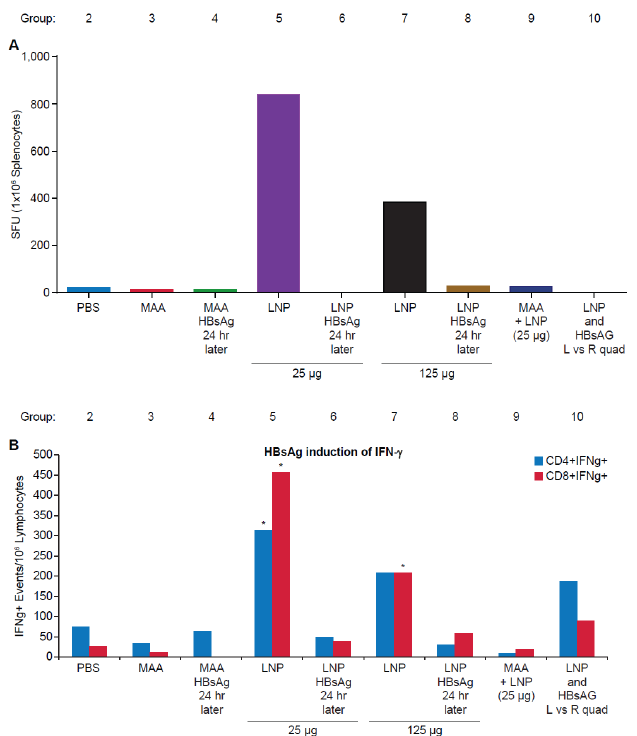
Figure 3. HBsAg-specific T-cell responses in BALB/c Mice. Spleens from five randomly selected mice out of ten immunized mice/group were collected, pooled, and processed two weeks after final vaccination. ( A ) The total HBsAg-specific T-cell response was evaluated using the IFN- γ ELISPOT assay to determine IFN- γ producing spots per million (SFU) splenocytes; or ( B ) HBsAg-specific CD4+ and CD8+ T cells that express IFN- γ were determined by Intracellular FACS assay (FACS ICS). ELISpot results are presented as the average value from pooled spleens, and the FACS ICS as T-cell events per million